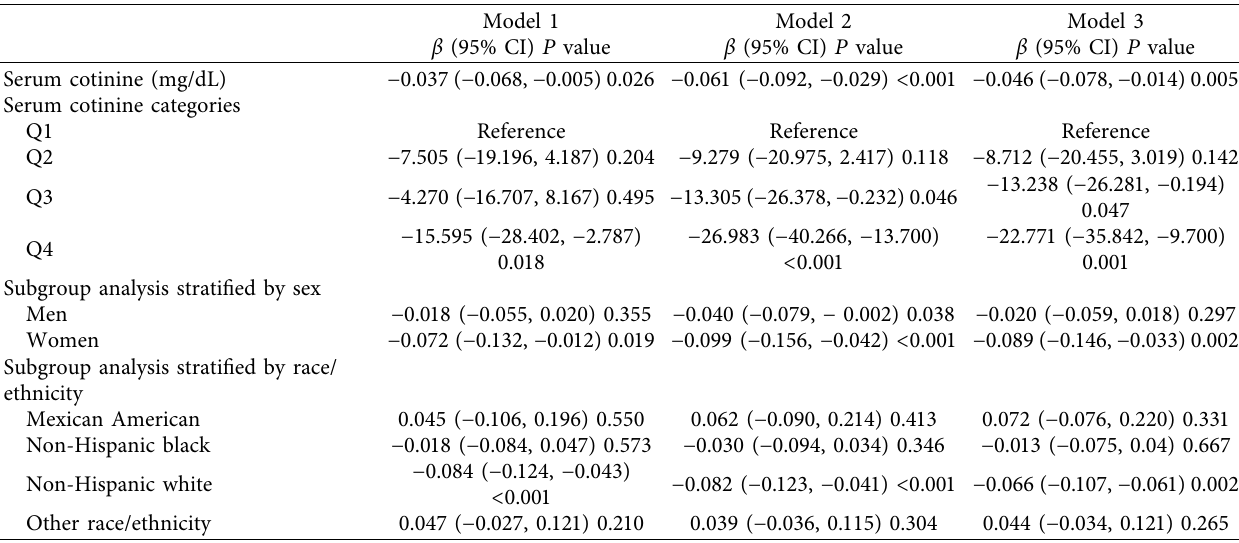
Table 2: The association between serum cotinine (ng/mL) and lumbar bone mineral density (mg/cm 2